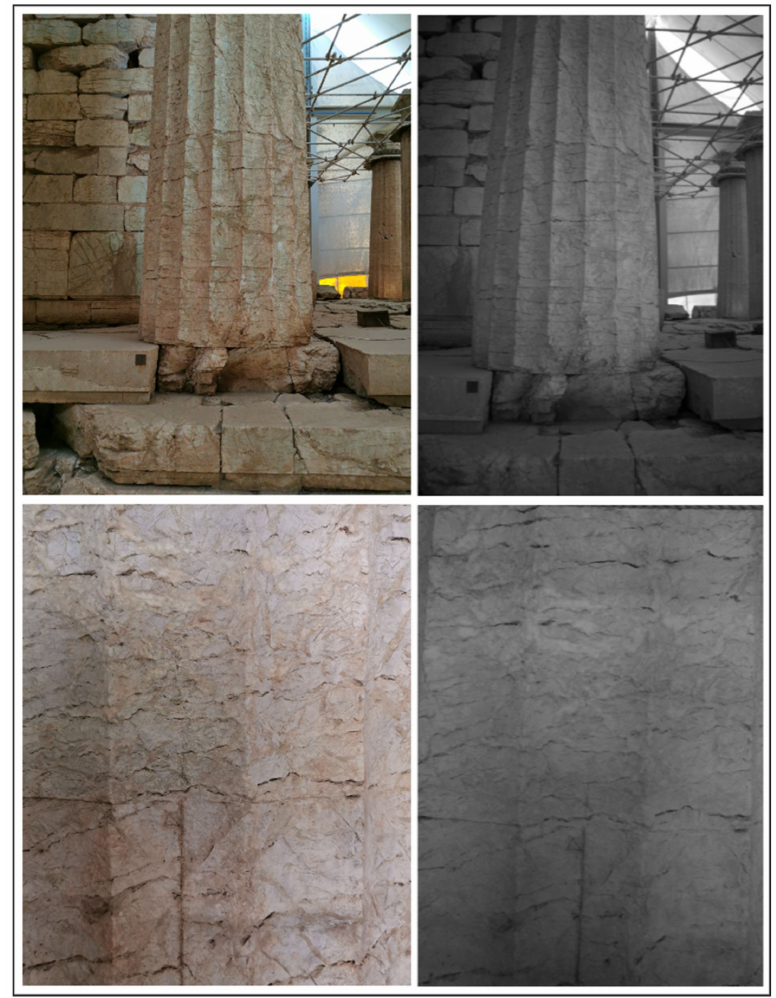
Figure 4. Color ( left ) and near-infrared reflectance ( right ) images of the same column captured at the Temple of Apollo Epikourios at Bassae, from further and closer